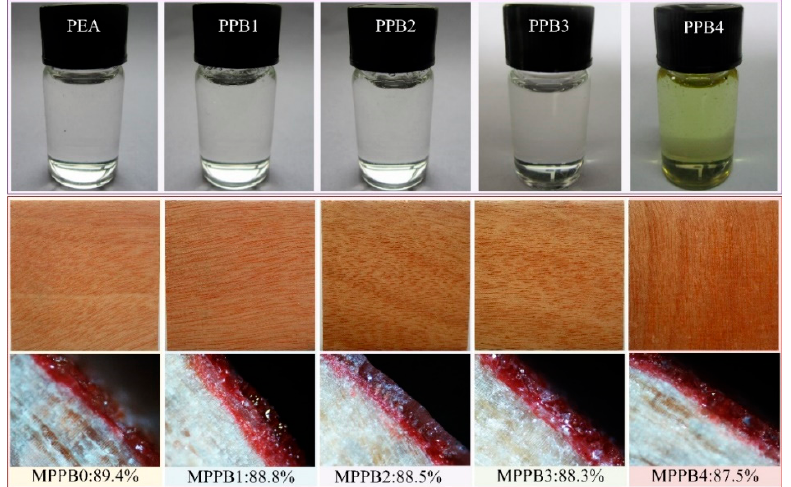
Figure 4. Digital photographs of the flame retardants and their resulting transparent fire-retardant coatings.